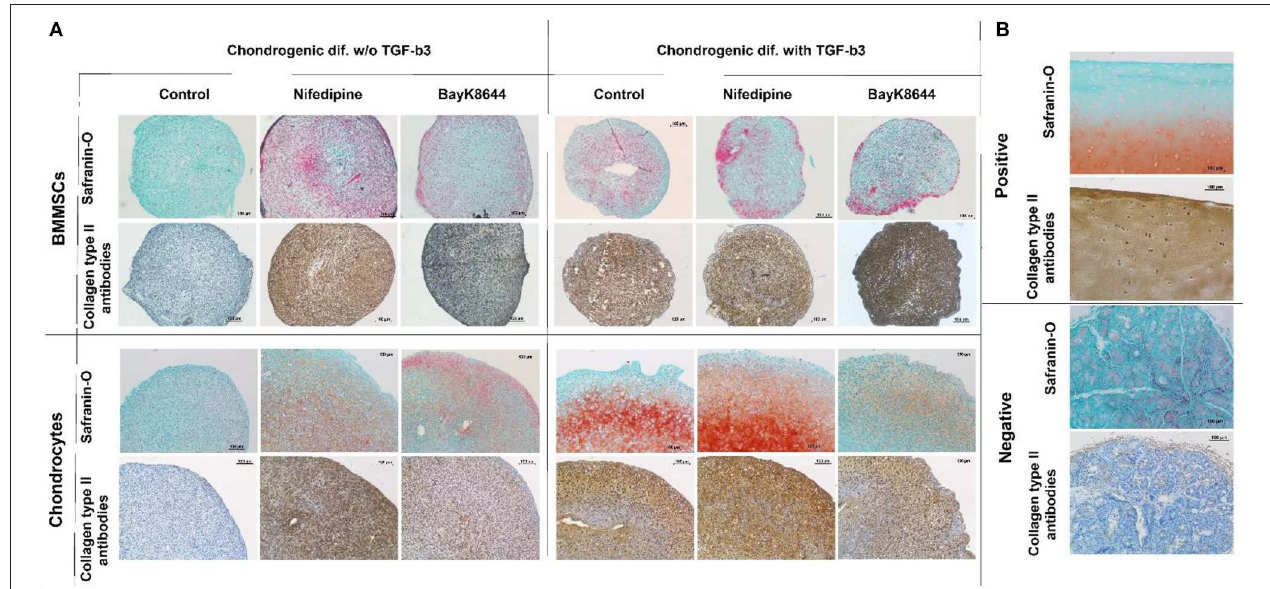
FIGURE 11 | Chondrogenic differentiation of BMMSCs and chondrocytes. Cells were incubated in chondrogenic differentiation medium with and without TGF β 3. Each group was divided into: Control, treated with nifedipine (10 µ M) and treated with BayK8644 (10 µ M). (A) Histological sections of cell pellets, stained with Safranin-O and anti-collagen type II antibodies, × 100 magnification. (B) Control staining for histological sections with Safranin-O and anti-collagen type II antibodies, where positive is cartilage tissue and negative—salivary